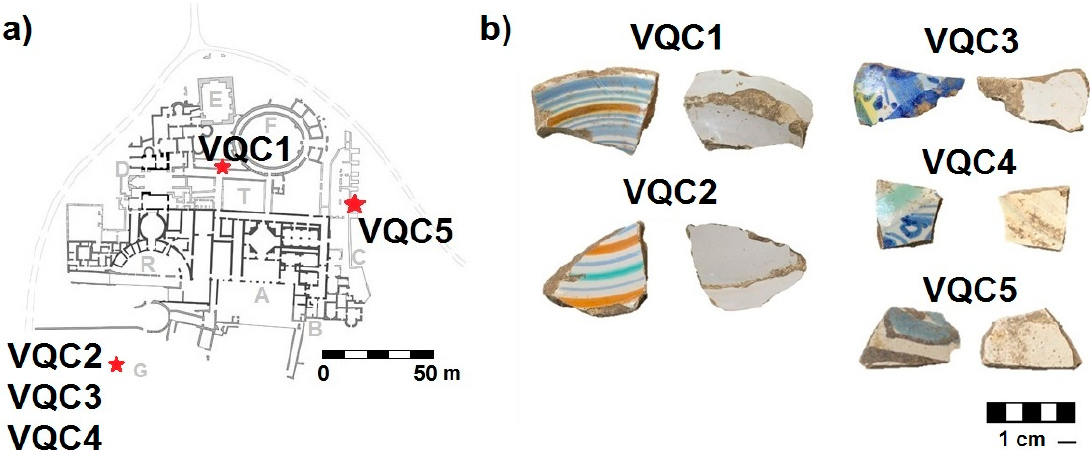
Figure 2. ( a ) Plan of the Villa dei Quintili and details of the sampled areas. Notes: A = representation area; B = private residences; C = Basis Villae; D = Frigidarium; E = Calidarium; F = Ludus-Viridarium; G = great cistern; R = Hippodrome; T = Arcades. ( b ) Photographs, front and reverse-side, of the analysed fragments.